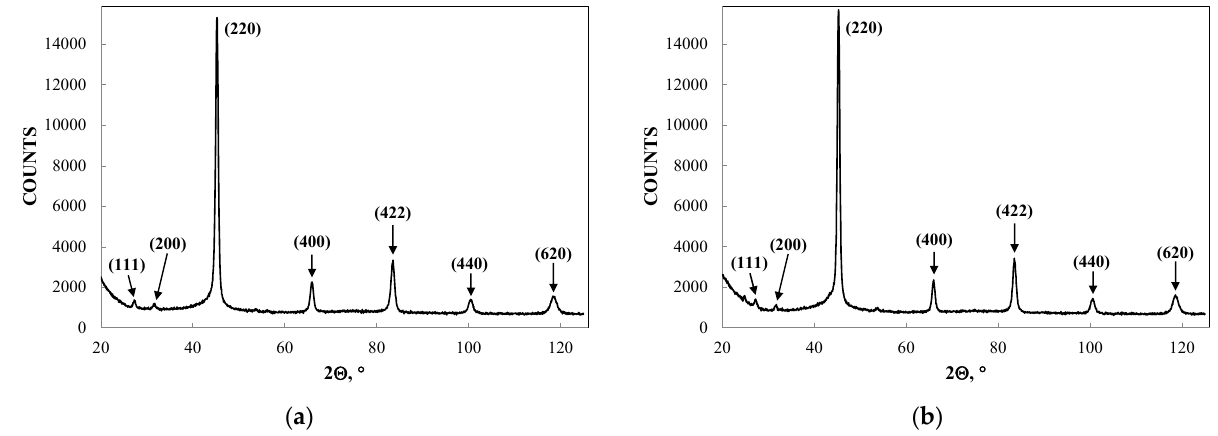
Figure 75. XRD patterns of FINEMET ribbons with different permeabilities: F1, μ r = 34,500 ( a ) and F2, μ r = 190,000 ( b ) with indicated Miller indices. Adapted from Ref. [102] with permission from